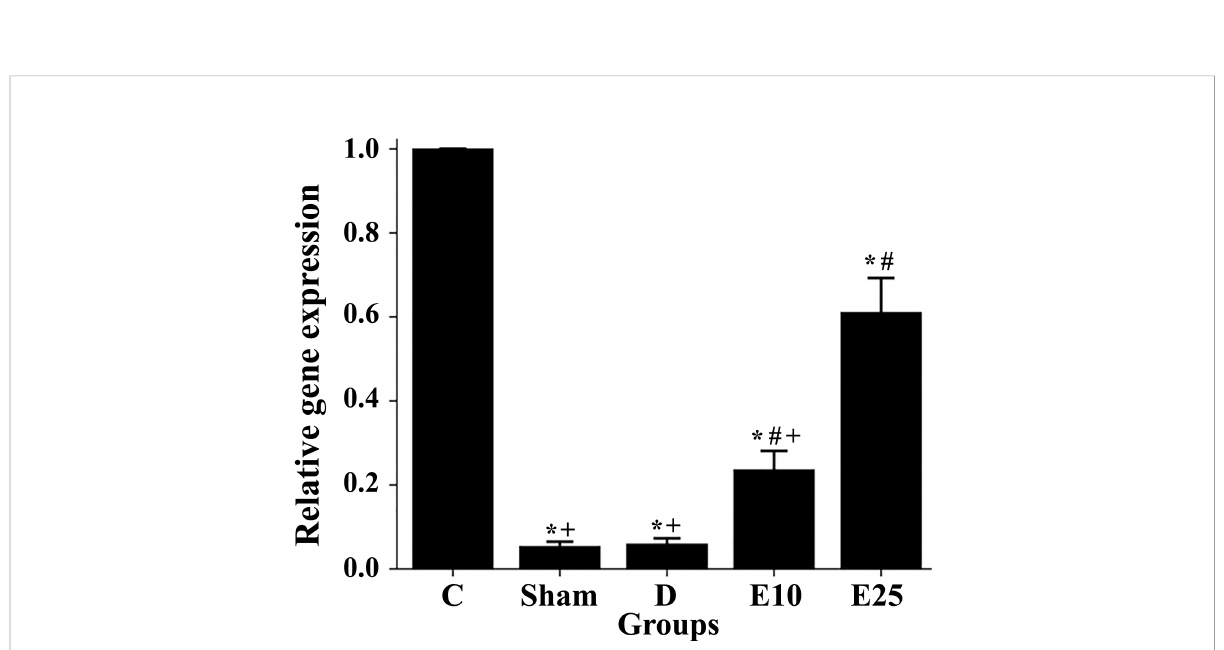
FIGURE 5 Changes in the kisspeptin mRNA levels in response to the empagli fl ozin in control and diabetes rats. C: control rats, D: diabetes group, sham: diabetic rats that received distilled water for 8 weeks, E10: empagli fl ozin-10 group (diabetic rats that received 10 mg/kg/day empagli fl ozin for 8 weeks, E25: empagli fl ozin-25 group (diabetic rats that received 25 mg/kg/day empagli fl ozin for 8 weeks. * Statistically different from the control rats (p ≤ 0.05), # statistically different from the diabetes rats (p ≤ 0.05), + statistically different from the E25 rats (p ≤